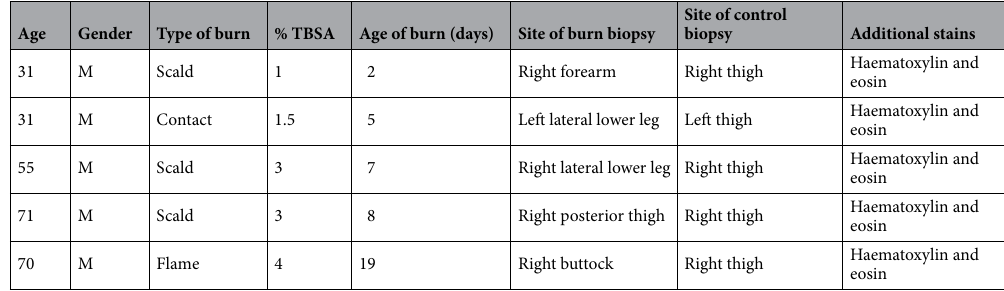
Age Gender Type of burn % TBSA Age of burn (days) Site of burn biopsy